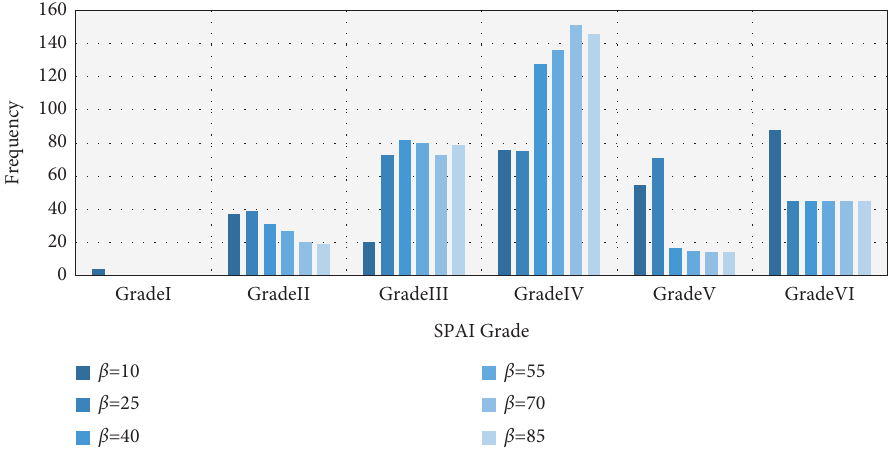
Figure 6: The distribution of SPAI grades with different impedance coefficients.